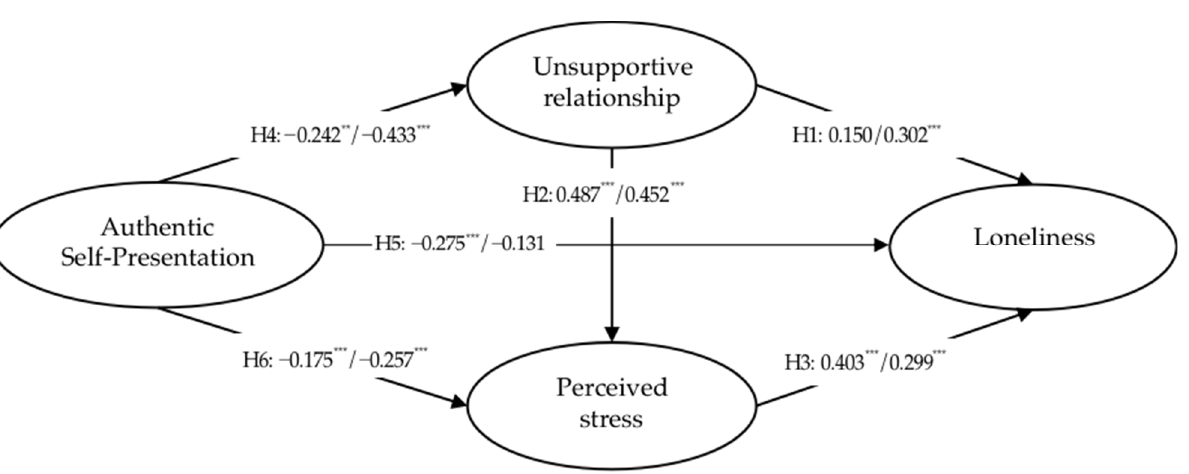
Figure 1. Assessment of structural model (urban n = 188, rural n = 168). Notes: path coefficients: urban/rural; ** p < 0.01, *** p < 0.001.